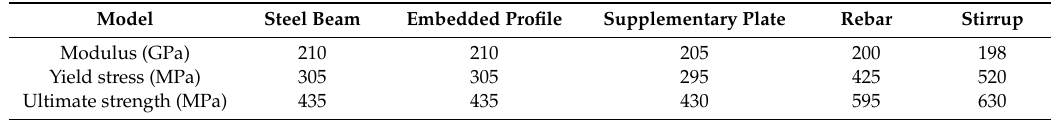
Table 1. Structural and reinforcing steel properties.